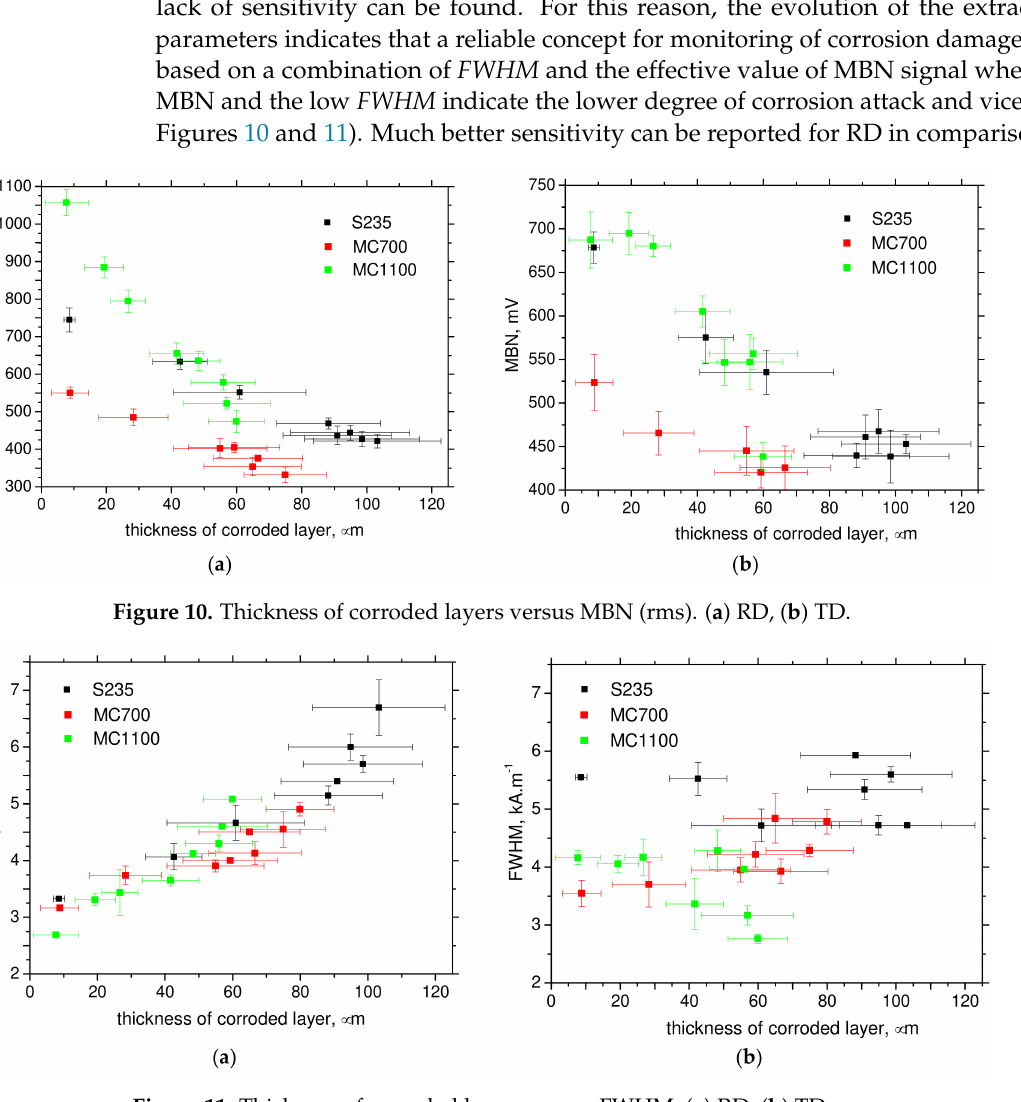
Figure 11. Thickness of corroded layers versus FWHM. ( a ) RD, ( b )